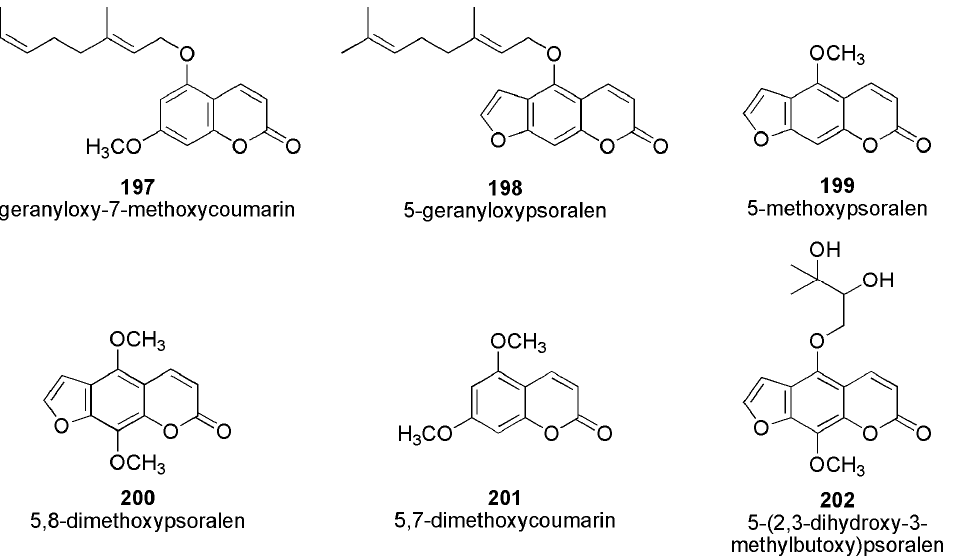
Figure 65. Structures of compounds isolated from Citrus peel.